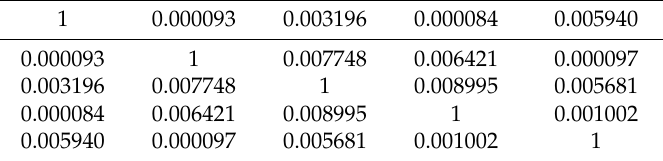
Table 5. Sensor placement scheme.